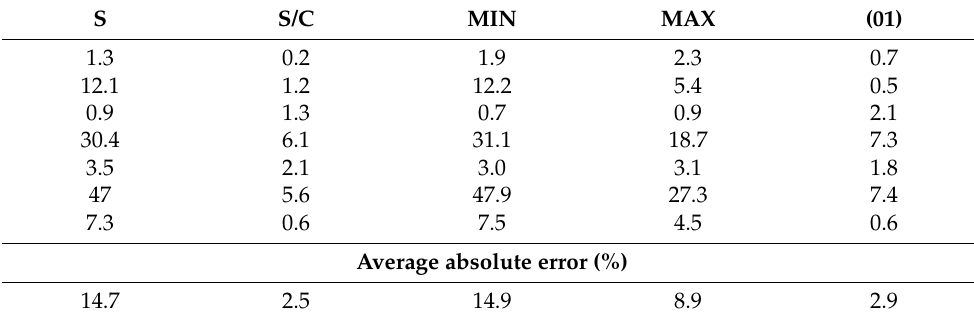
Table 4. Absolute error (|C p − C k |) occurring in each calibration method